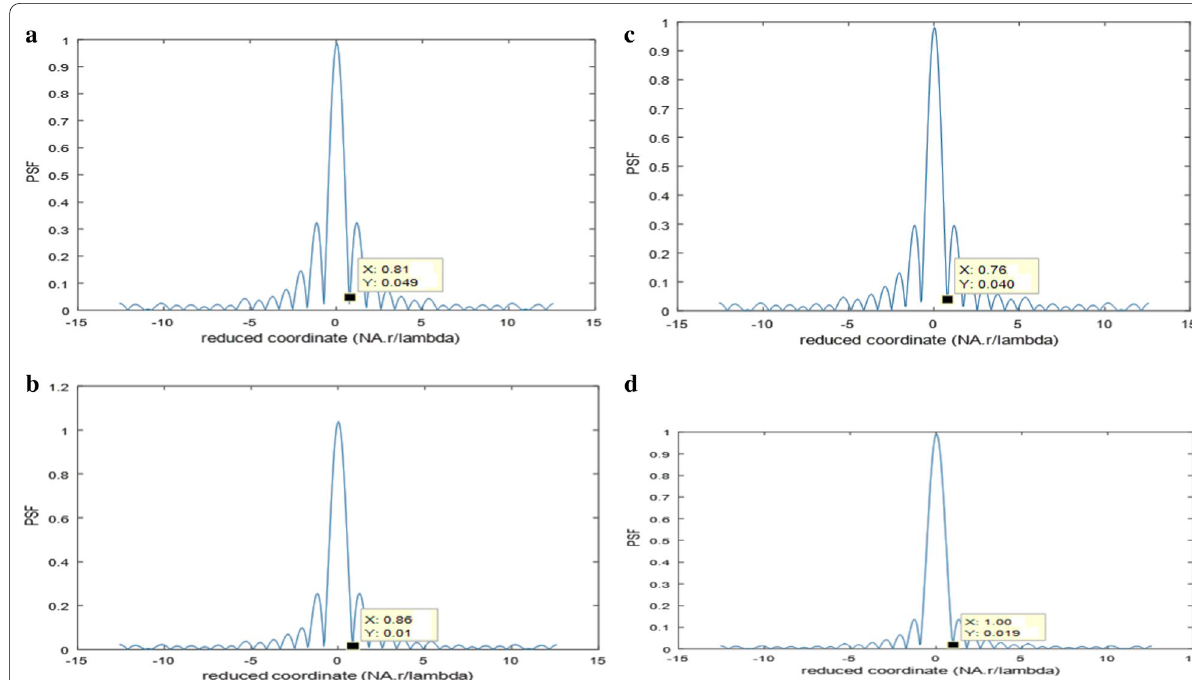
Fig. 4 a Normalized PSF for the first model of polynomial aperture using FFT technique. The total diameter frequency is located at W cut-off 0.81. b The normalized PSF for the linear aperture using FFT technique. The diameter = spatial frequency is located at W cut-off 0.86. c The normalized PSF for the quadratic aperture using FFT technique. The diameter = cut-off spatial frequency is located at W cut-off 0.76. d The normalized PSF for the uniform circular aperture using FFT technique. The diameter = pixels, and the cut-off spatial frequency is located at W cut-off =